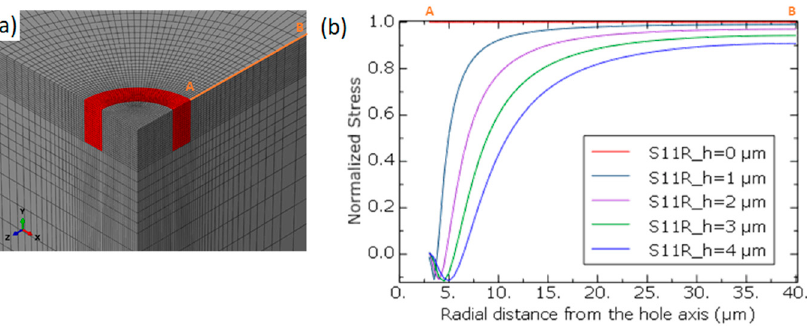
Figure 2. A numerical model for the sizing of the FIB-DIC test, ( a ) a view of the mesh in the zone of interest, red is the ablated zone, and ( b ) an evolution of the normalized stress along (A, B) as a function of the ablation depth.